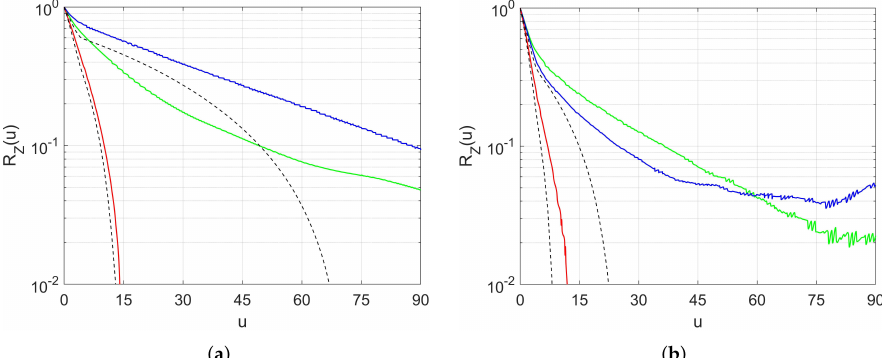
Figure 6. Spatial correlation R Z ( u ) in [S1] ( a ) and in [S2] ( b ), as a function of u in voxel-size units, when the lag u is set along the principal directions identified in Figure 5 (solid lines). The black broken lines are the correlations in a PEM/PSM sample, along the directions of the minor and major axes of the